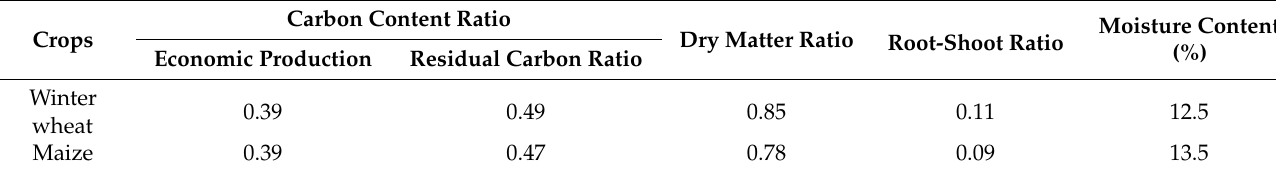
Table 5. Residual carbon ratio, dry matter ratio, and root–shoot ratio of crops. Crops